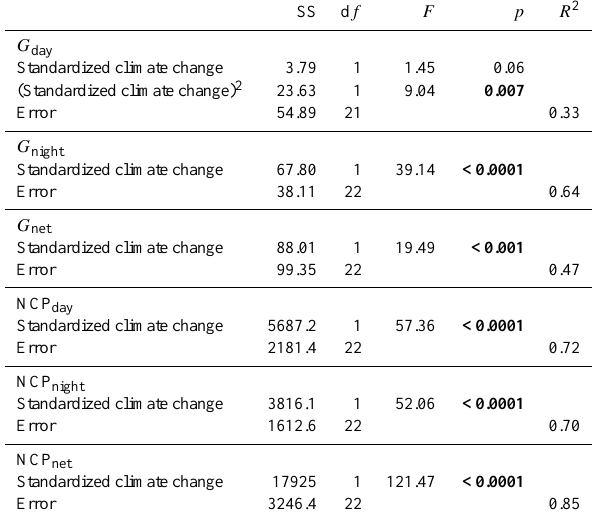
Table 2. Regression results for the treatment experiments: G day , G night , and G net versus standardized climate change (Fig. 3a, c, e) and NCP day , NCP night , and NCP net versus standardized climate change (Fig. 3b, d, f). Bold values indicate a statistically significant p value at α <0.05. SS d f